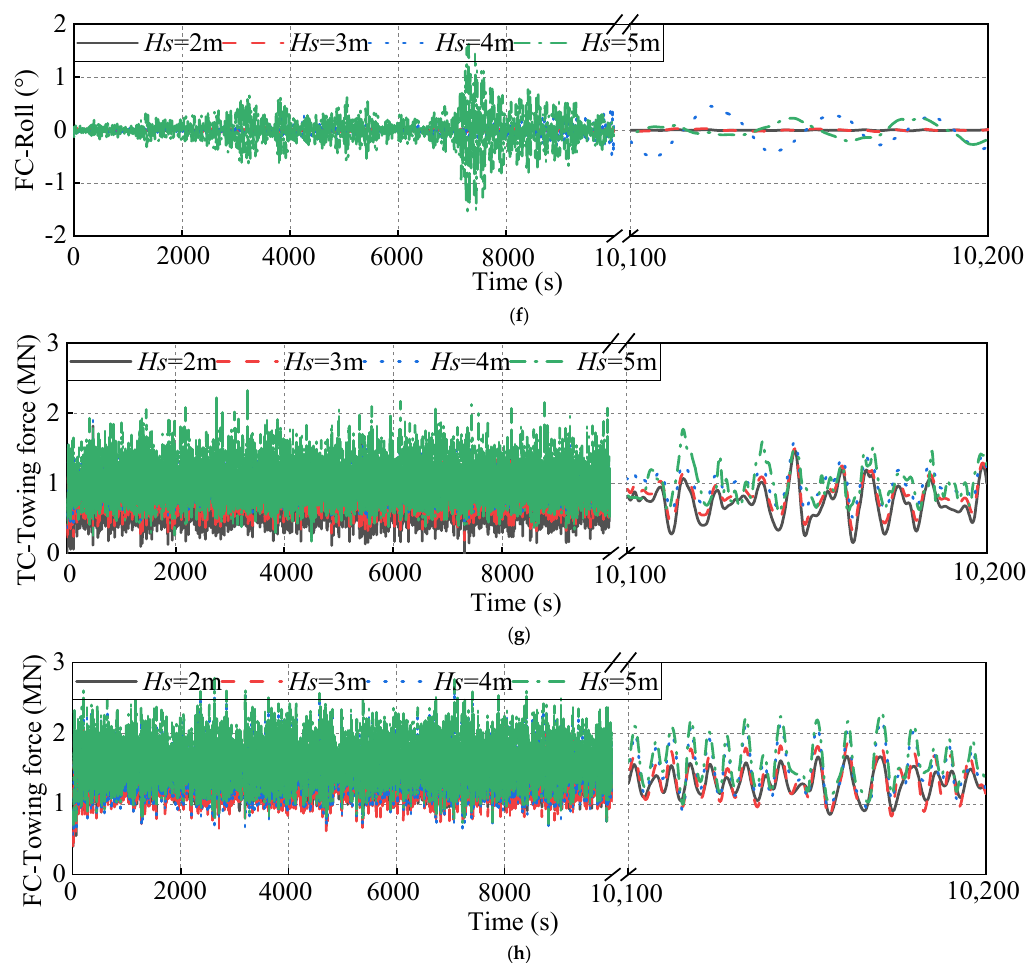
Figure 12. Time series of the SFOWT under different wave height conditions ( Tp = 8.9s). ( a ) Heave motion of TC-SFOWT, ( b ) heave motion of FC-SFOWT, ( c ) pitch motion of TC-SFOWT, ( d ) pitch motion of FC-SFOWT, ( e ) roll motion of TC-SFOWT, ( f ) roll motion of FC-SFOWT, ( g ) towing force of TC-SFOWT, ( h ) towing force of FC-SFOWT.